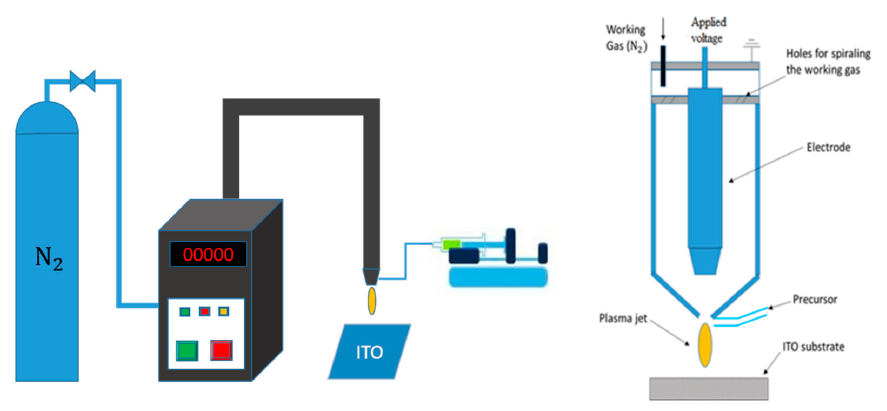
Figure 10. Schematic diagram of the AC plasma deposition